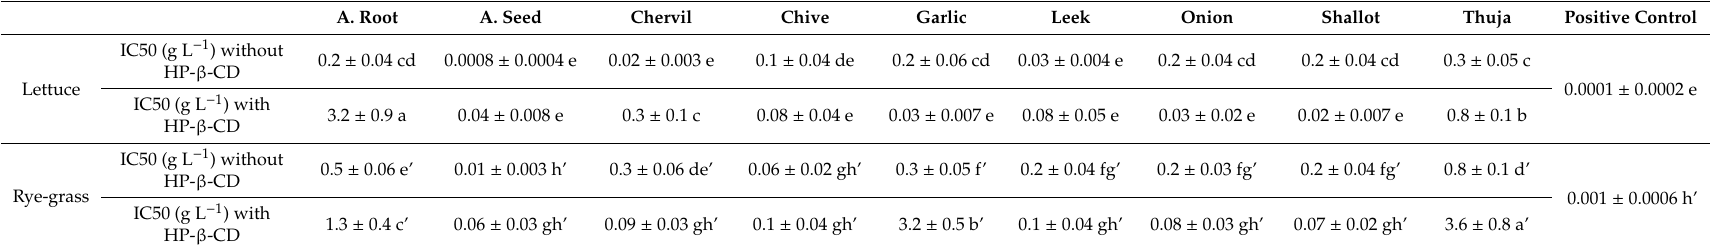
Table 5. IC50 of EO’s phytotoxic activity (inhibition of seedling’s growth) obtained by contact assay, against lettuce and